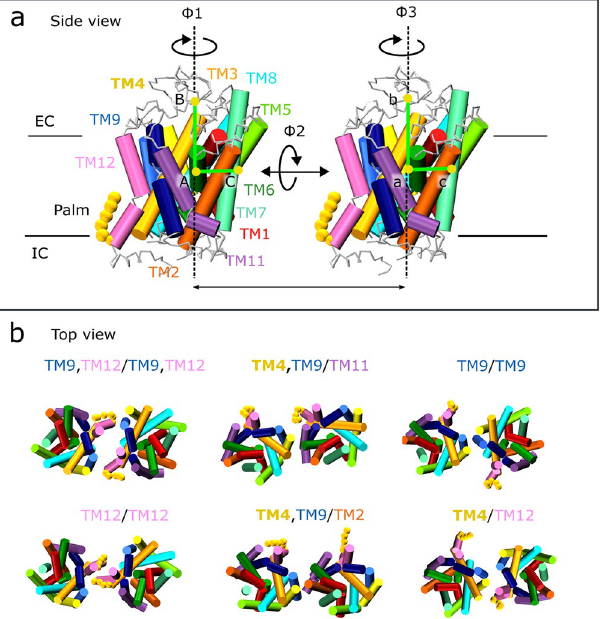
Figure 2. Dimer cluster comparison between the two systems, hDAT and hDAT-palm. Depicted in ( a ) is a transmembrane (TM) overview of hDAT shown from the side with respect to the membrane normal. The helices are individually color-coded using the same coloring scheme as applied throughout the article. Highlighted in bold spheres is the palmitoyl group (palm) covalently bound to TM12. The two angles, 3, are used for describing the individual protomer’s relative orientation. Depicted in ( b ) are the common top clusters observed in both the hDAT and hDAT-palm simulations, with the exception of the TM12/TM12 dimer, ϕ which is only detected 0.1% of the time in the hDAT-palm simulations. For a full view of the representative dimers of all top clusters of the hDAT and hDAT-palm system see Supplementary Fig.